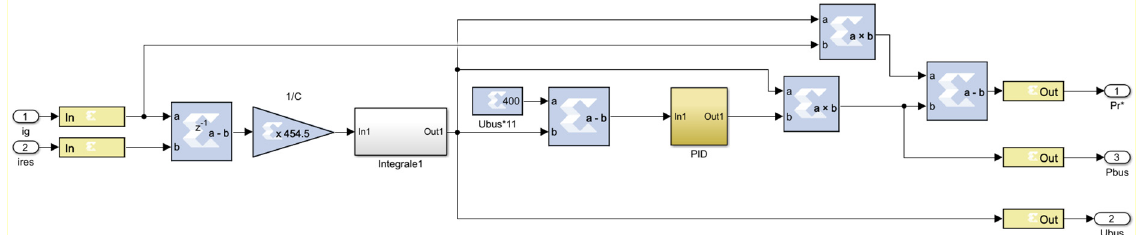
Figure 13. Hardware design of VCS-PI controllers for DC bus voltage. Where (*) is added to distinguish between the actual and the references variables.